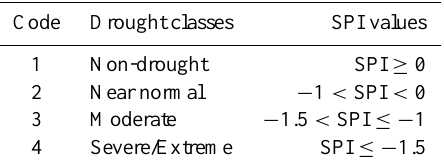
Table 2. Drought classification of SPI (modified from Mckee et al.,